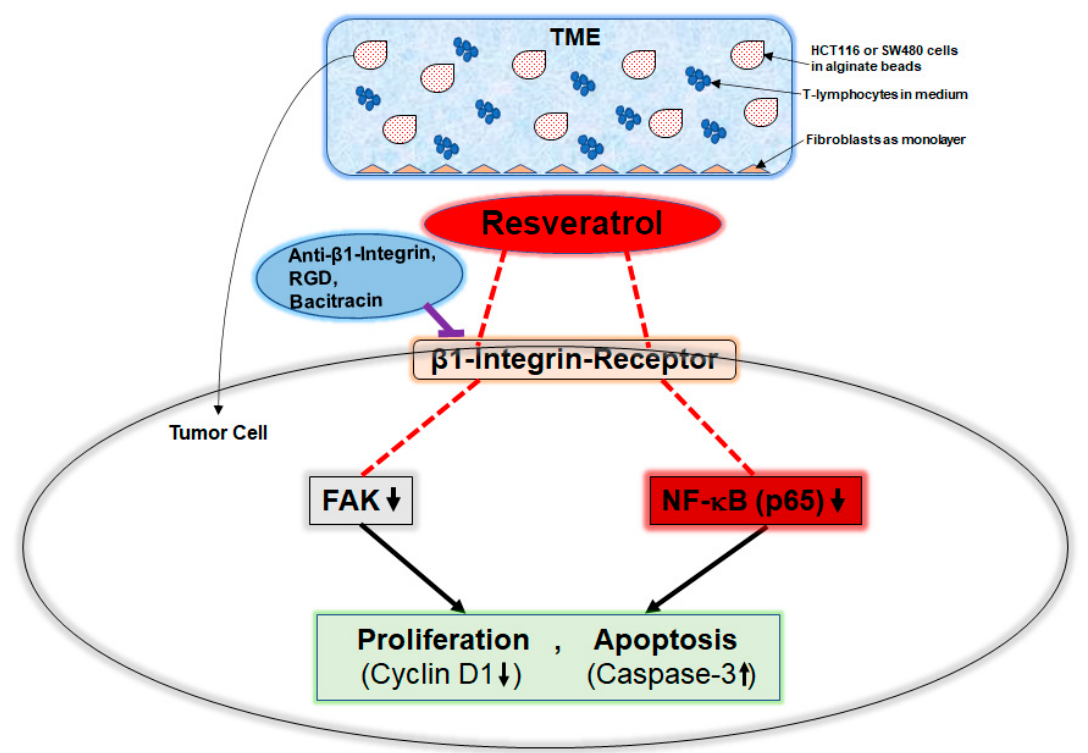
Figure 6. Working model demonstrating resveratrol-mediated anti-proliferative and anti-viability activity through modulation of the β 1-integrin receptor in CRC cells in the pro-inflammatory TME.